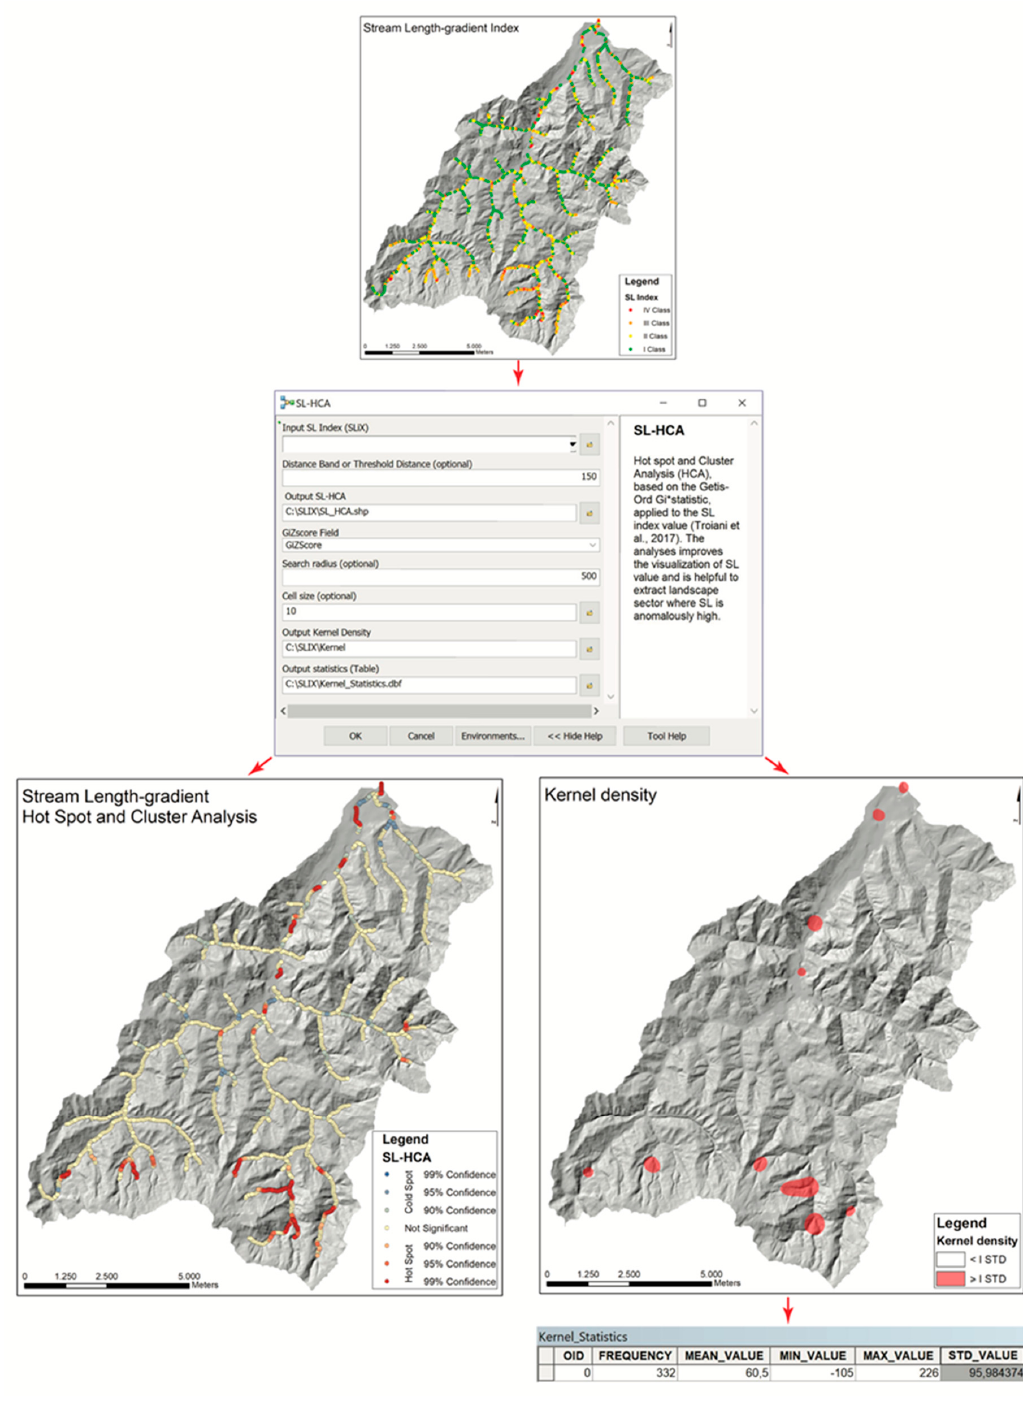
Figure 5. Stream Length-Gradient Hot Spot and Cluster Analyses (SL-HCA) model tool in the SLiX toolbox. The output derived from the SLiX model tool represents the input data for this model tool, which allows the spatial distribution of cold and hotspots (figure on the left) to be derived, and the relative kernel density (figure on the right). The kernel density mapping has been here adopted a classification based on a standard deviation distance from mean.